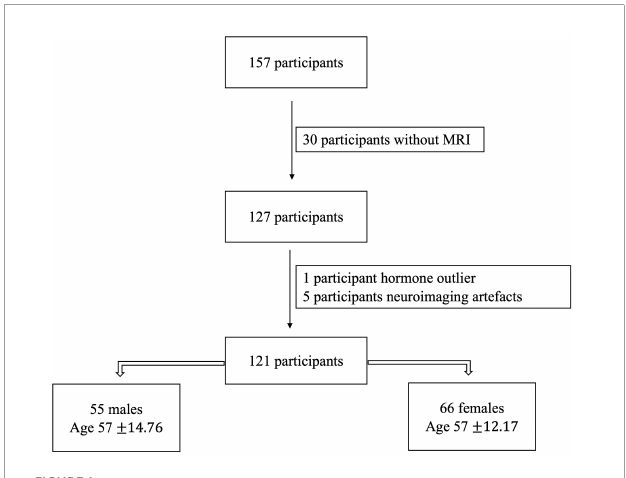
FIGURE1 The initially collected number of participants and after following the exclusion criteria, the final number of our